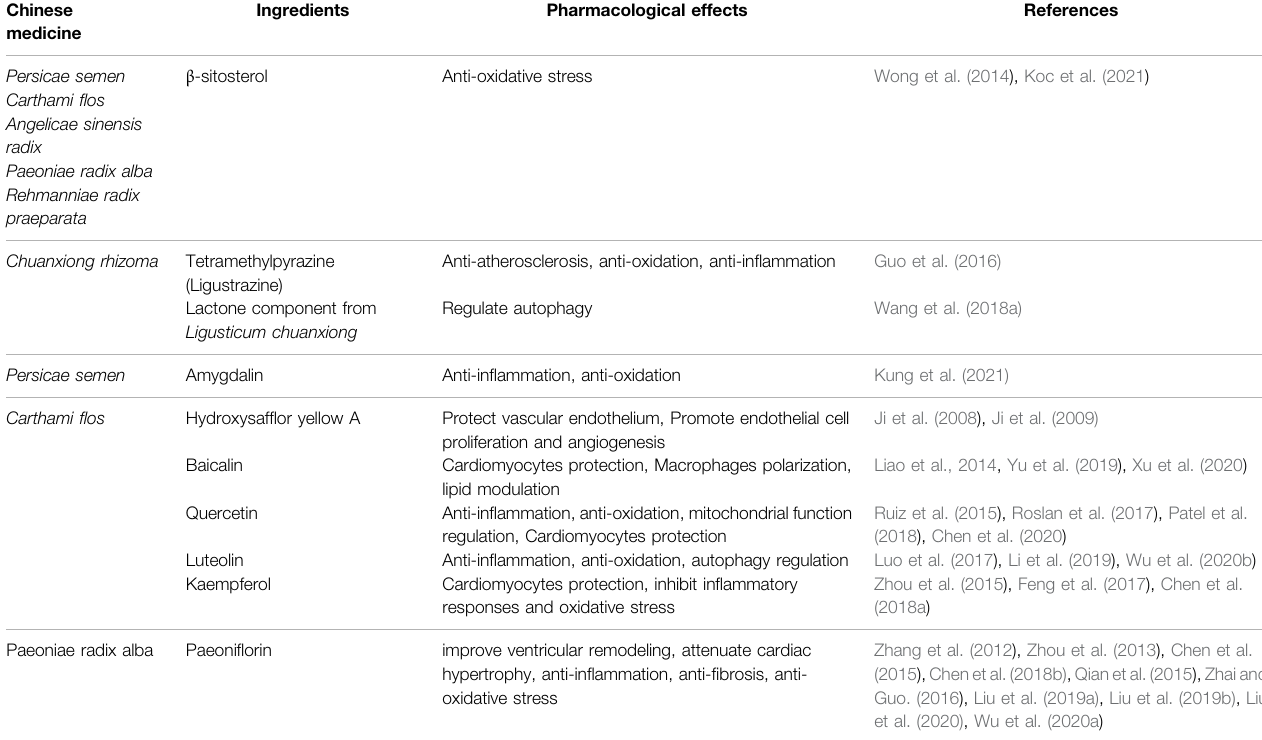
TABLE 2 | The main active ingredients from THSWD in protection of